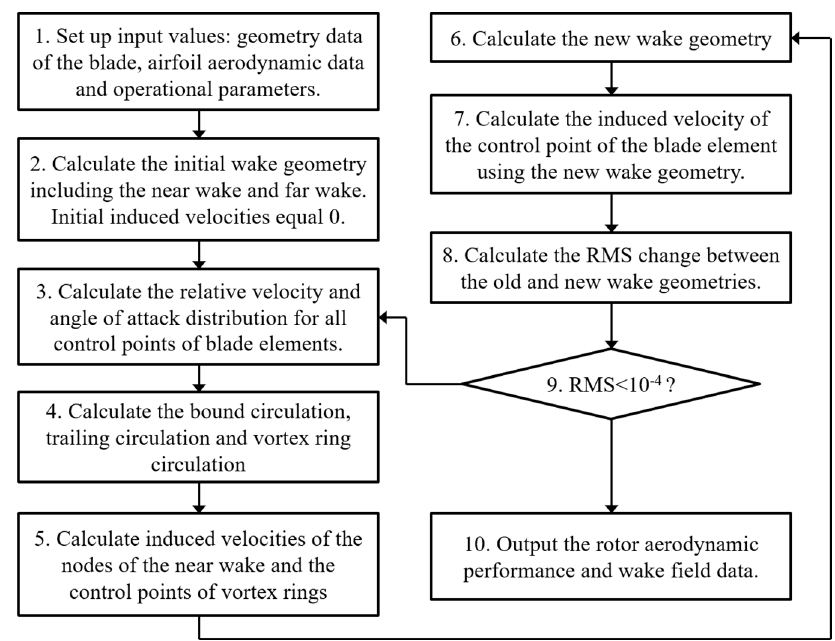
Figure 6. Flowchart of the simplified FVW model.